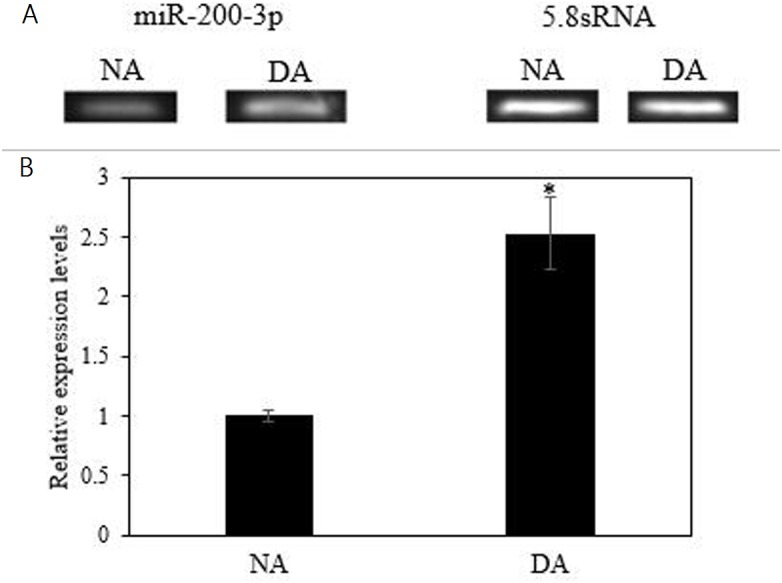
Effect of estivation on the relative expression of miRNA-200-3p.Representative bands show RNA transcript levels amplified by RT-PCR. Band intensities from the RT-PCR samples were normalized to either 5.8S rRNA (microRNA) band amplified from the same sample. Data are means ± SE (N = 5 independent trials on tissue from different animals). “*” Indicates a significant difference from the corresponding control (p < 0.05).